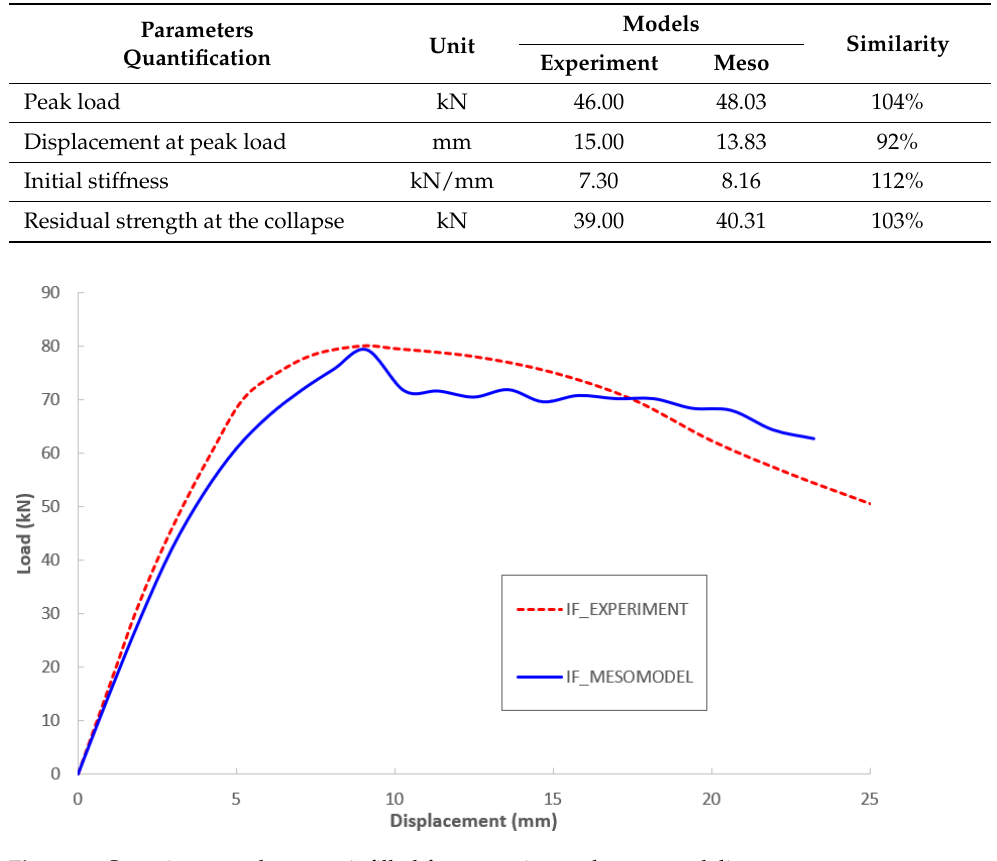
Figure 6. Capacity curve between infilled frame testing and meso modeling.